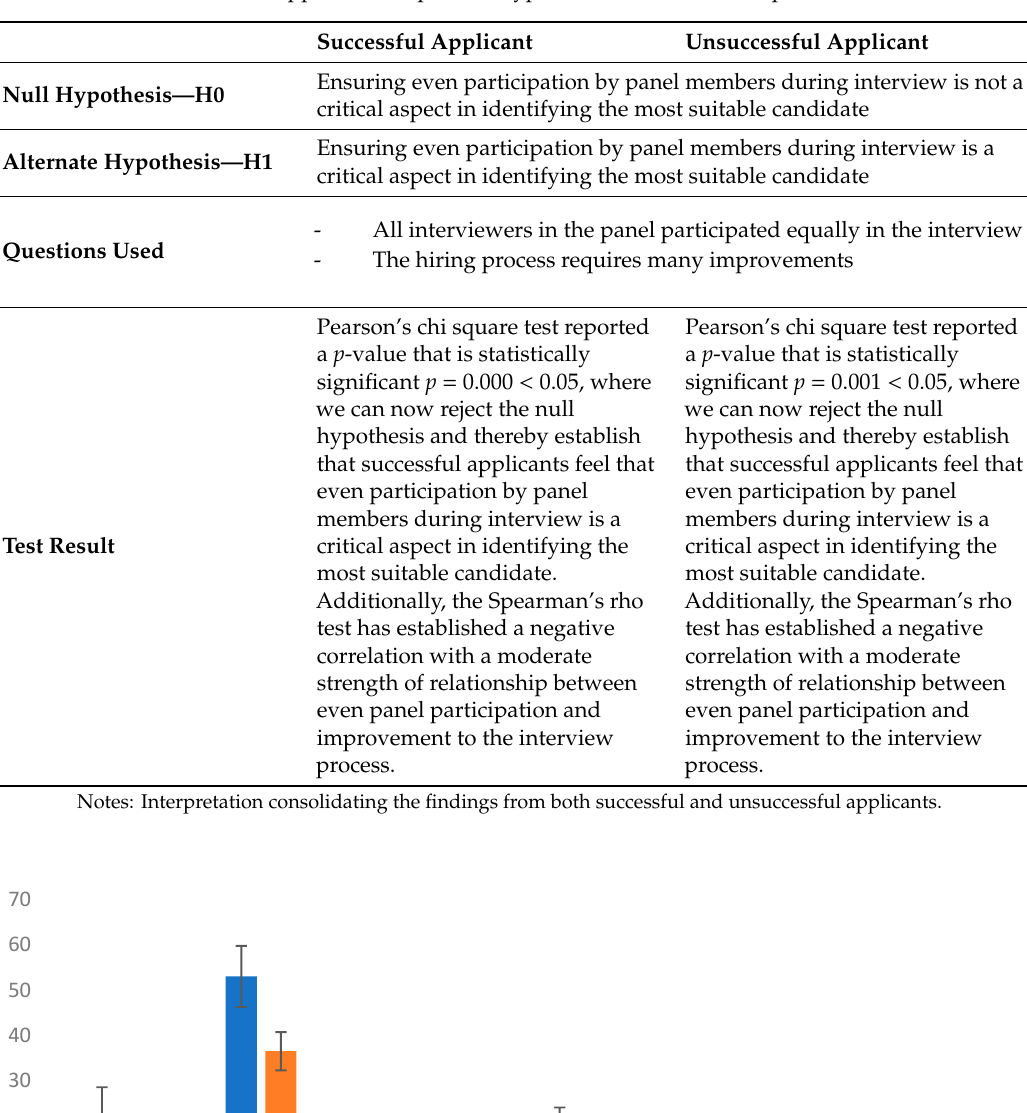
Table 4. Applicant Perspective Hypothesis 2—Panel Participation.